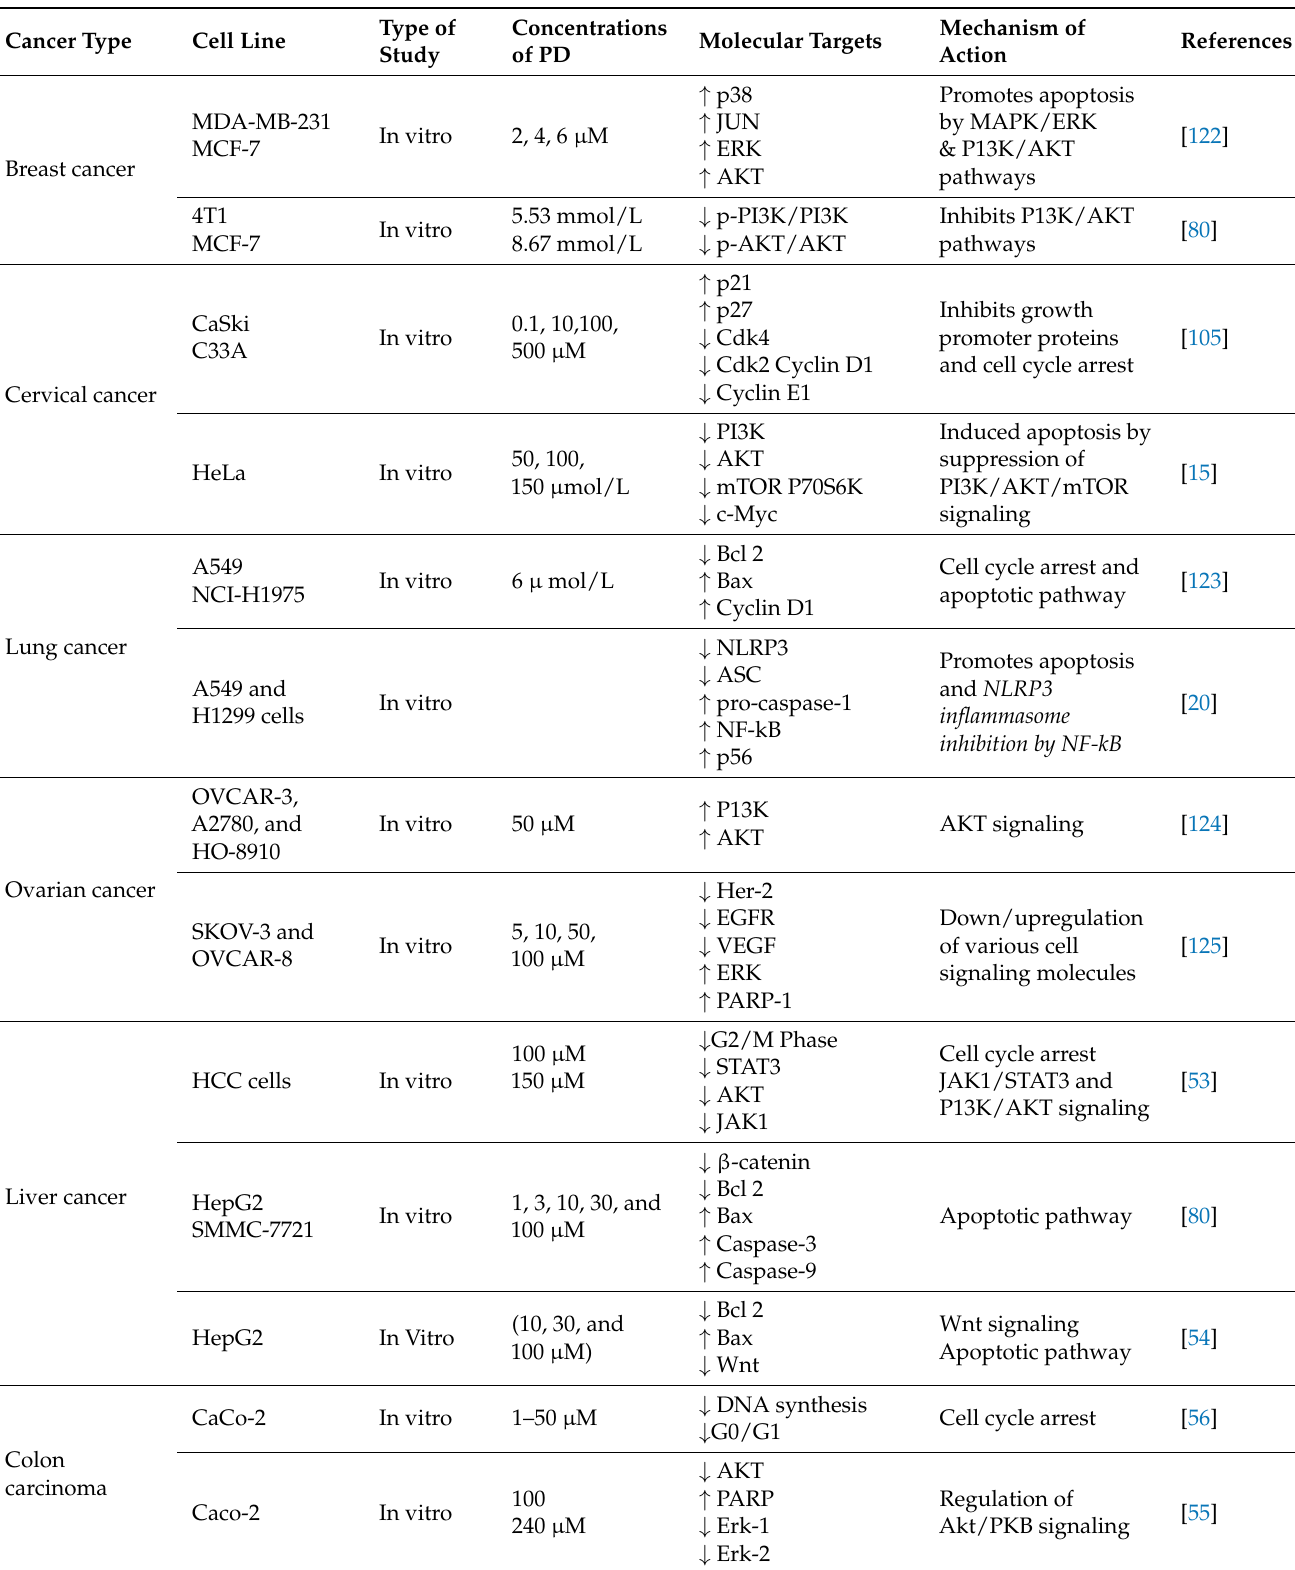
Table 2. Anticancer activity of polydatin on different types of